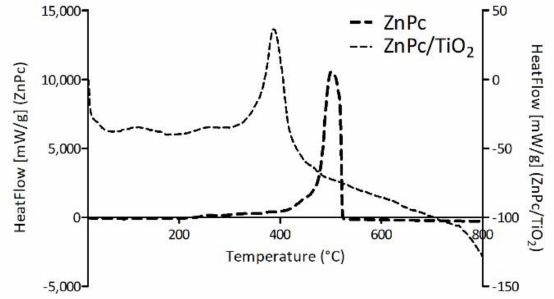
Figure 12. Comparison of the HeatFlow curves for neat phthalocyanines and phthalocyanine- grafted TiO 2